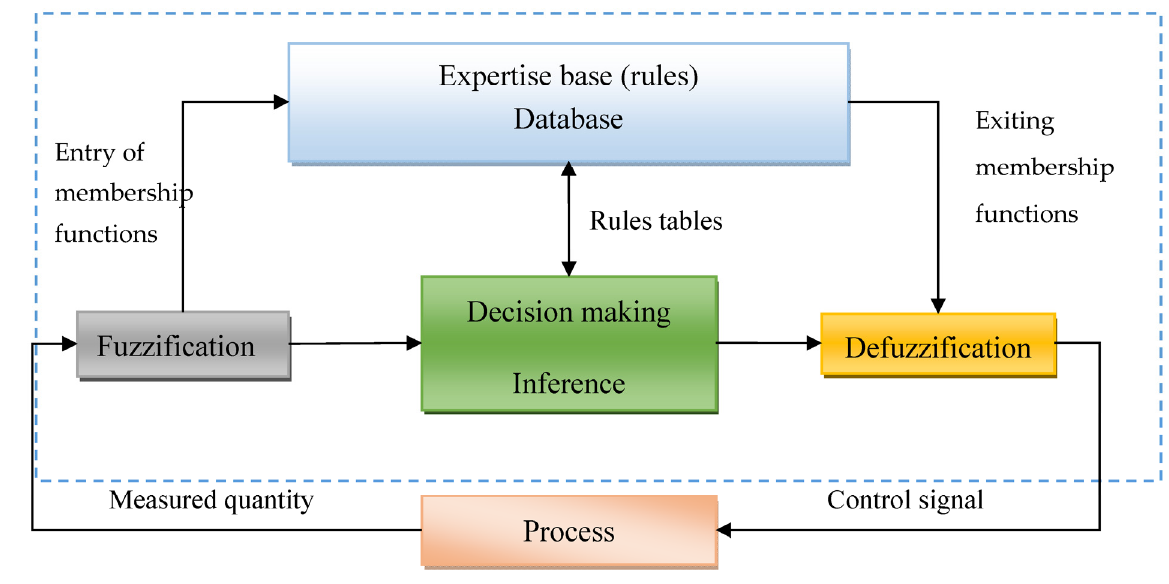
Figure A1. Structure of a fuzzy regulator.